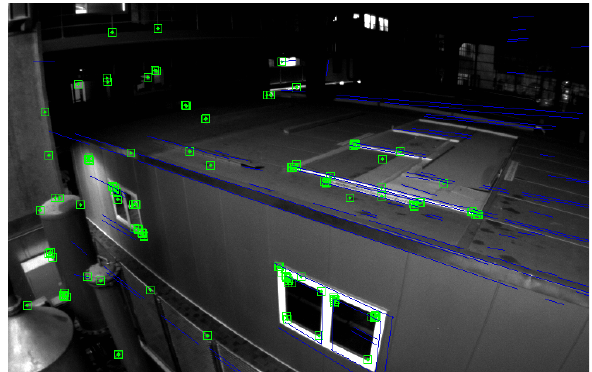
Figure 2. Point-line fusion tracking. When the indoor scene has fewer feature points (green markers in the figure) extracted due to factors such as lighting and texture, line features (blue line markers in the figure) are introduced as additional